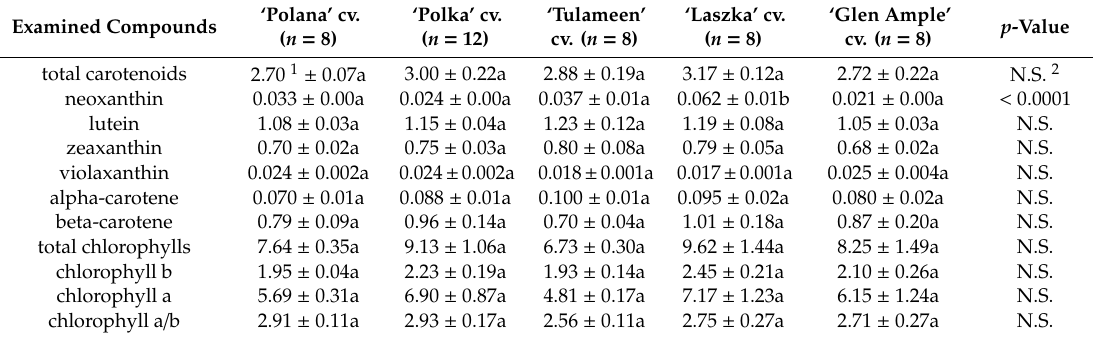
Table 5. The content of carotenoids (mg 100 g − 1 FW) and chlorophylls (mg 100 g − 1 FW) in examined raspberry leaves depending on cultivar. Data are presented as the mean ± SE with ANOVA p -value. Examined